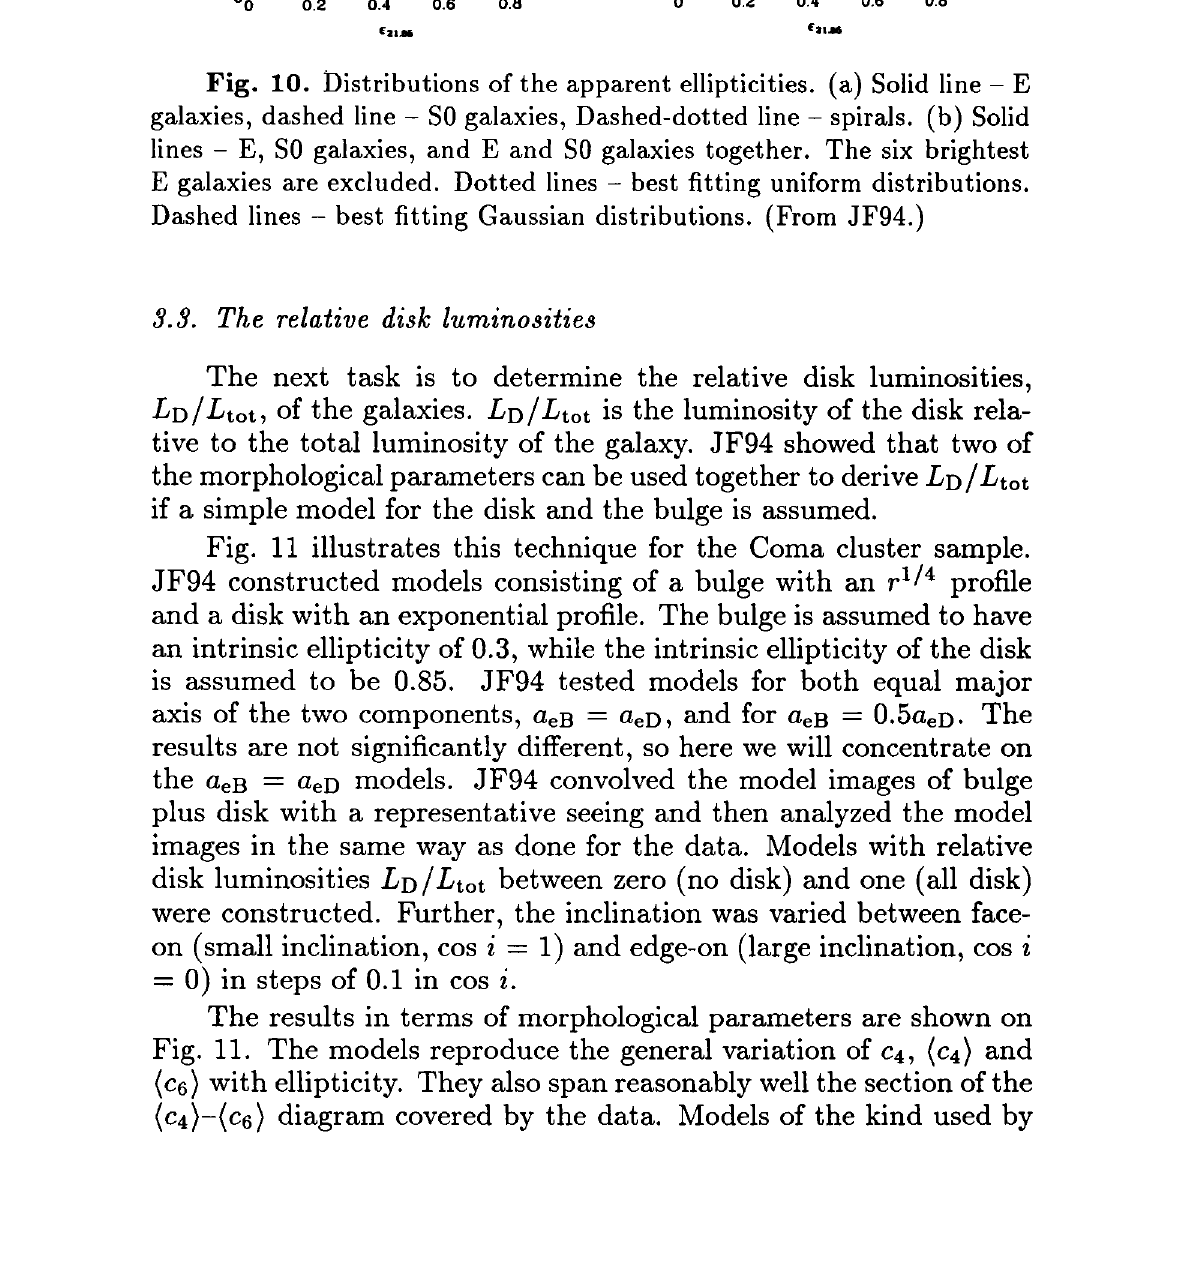
Fig. 10. Distributions of the apparent ellipticities. (a) Solid line - E galaxies, dashed line - SO galaxies, Dashed-dotted line - spirals, (b) Solid lines - E, SO galaxies, and E and SO galaxies together. The six brightest E galaxies are excluded. Dotted lines - best fitting uniform distributions. Dashed lines - best fitting Gaussian distributions. (From